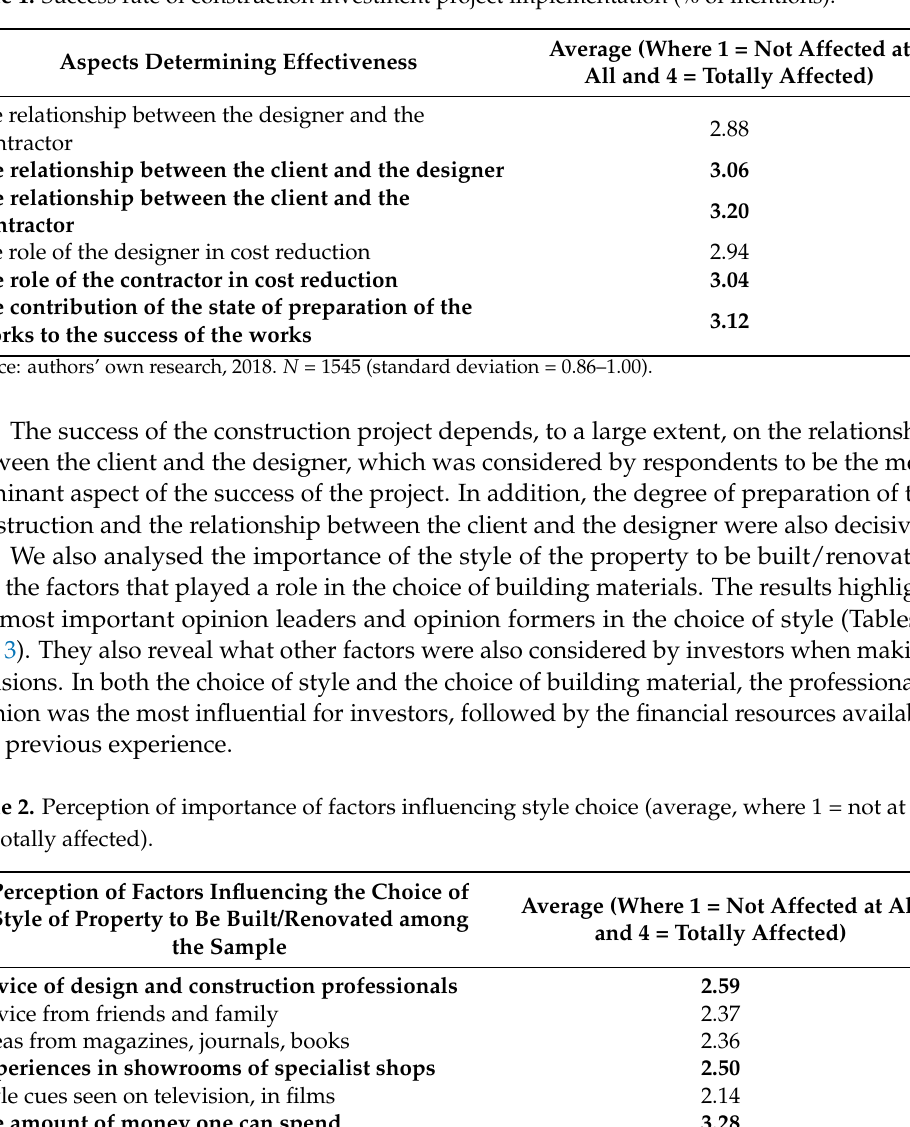
Table 1. Success rate of construction investment project implementation (% of mentions).